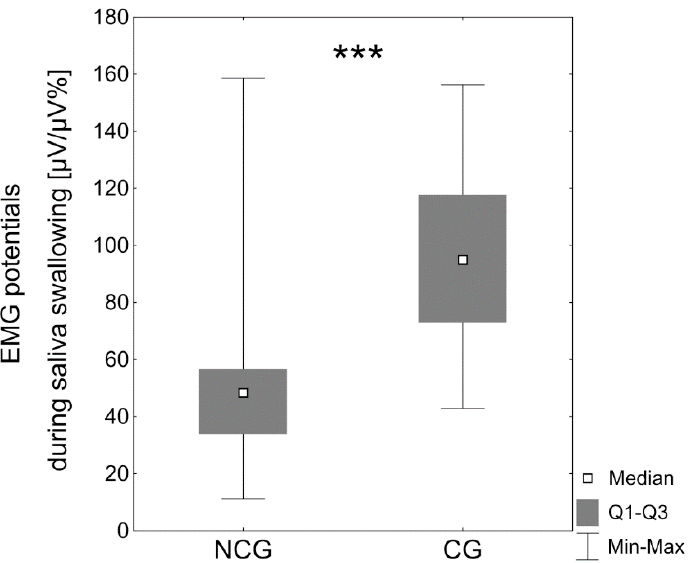
Figure 2. EMG potentials of the upper lip [µV/µV%] during saliva swallowing in the noncleft group (NCG) and the cleft group (CG); *** p < 0.0001. The EMG activity of the superior orbicularis oris muscle during lip compression was significantly higher in the cleft group (Mdn = 115.6 µV/µV%) compared with the subjects without clefts (Mdn = 96.9 µV/µV%, p < 0.05) (Table 3, Figure 3).